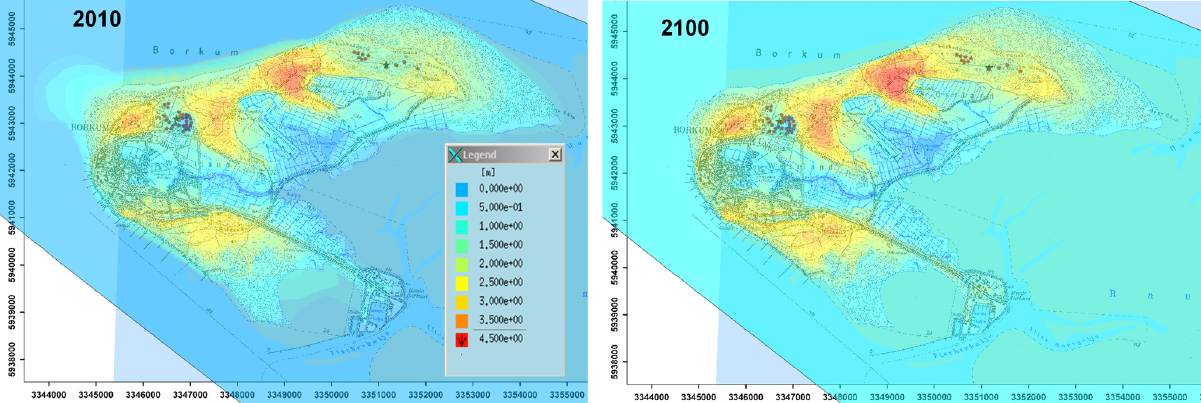
Fig. 16. Computed groundwater table for 2010 (left panel) and 2100 (right panel) by using the IPCC-A2 emission scenario. The groundwater recharge will increase linearly by 10% (average scenario).